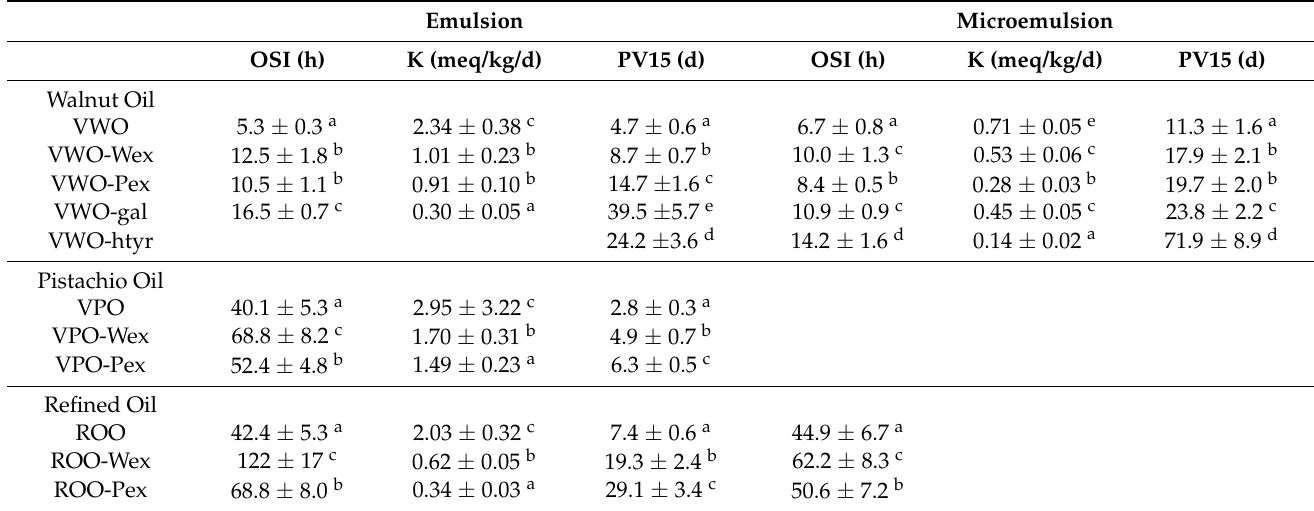
Table 3. Results of Rancimat and oven tests * of oil formulations in emulsion and microemulsion ( n = 3). Emulsion